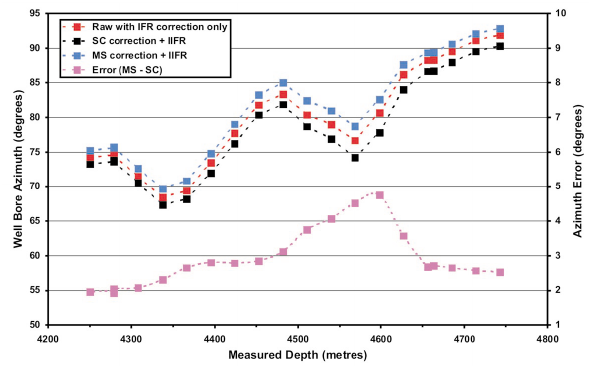
Fig. 6. A comparison of MWD survey correction methods showing the wellbore azimuth, over 2 days of drilling, at regular intervals along the well path with respect to the measured depth. The red trace is the raw measured azimuth without any corrections for mag- netic interference near the sensors (i.e. equivalent to LC with IFR correction only). The black trace shows the additional SC correc- tion that would be applied assuming all the magnetic interference was due to axial drill string interference. The blue trace is the final MS corrected azimuth which includes a correction of the cross-axial sensor data for other interference including magnetically suscepti- ble drilling fluid. Also shown is the difference between SC and MS in sense of MS-SC (lower pink trace). This indicates the azimuth error, as shown on the right hand y-axis, that would have been in- curred had the MS method not been